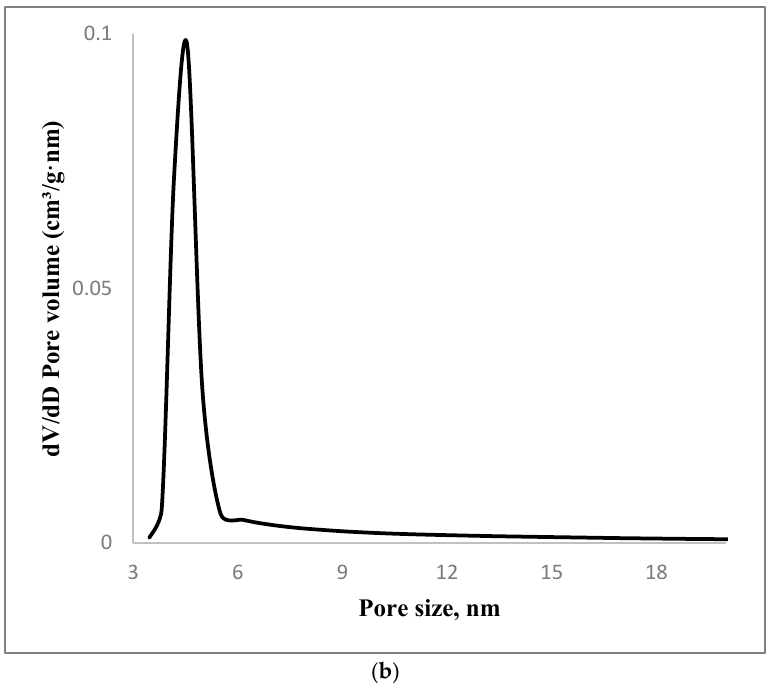
Figure 5. ( a ) N 2 adsorption–desorption isotherm of CuFe 2 O 4 -70%/rGO/HNT. ( b ) Pore size distribution of CuFe 2 O 4 -70%/rGO/HNT.